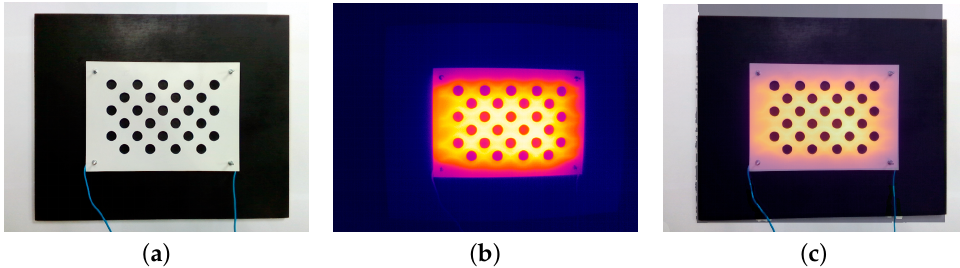
Figure 8. Calibration target board: ( a ) Seen with the color sensor; ( b ) Seen with the IRT sensor; and ( c ) After blending the color and thermal